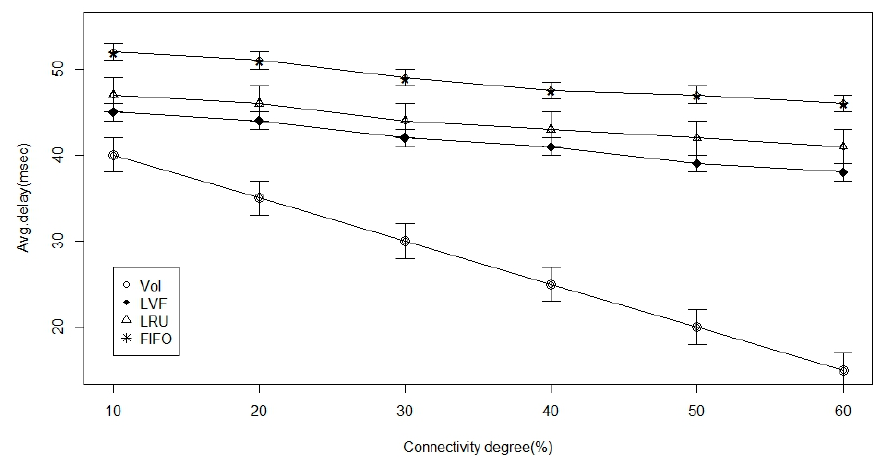
Figure 10. Average in network delay versus the connectivity degree percentage.